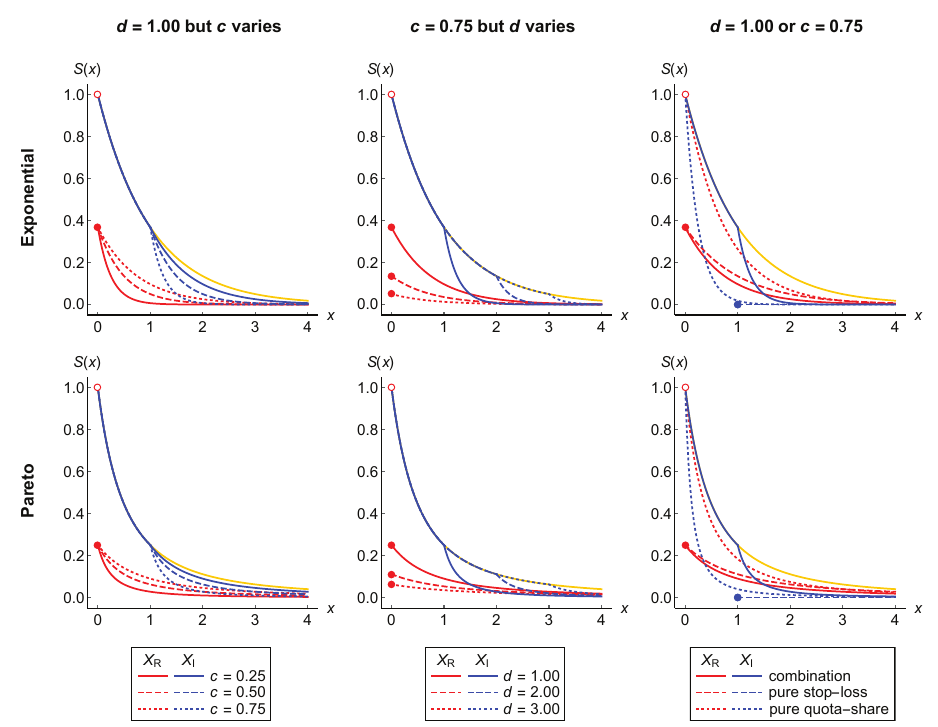
Figure 2. The curves of the survival functions S X stop-loss and quota-share reinsurance when d is fixed but c varies (on the left side) and when c is fixed but d varies (on the middle side). On the right side, they are compared to the curves of the survival functions under the pure stop-loss and the pure quota-share reinsurance. The yellow curve represents the survival function of the initial loss X that follows E ( 1 ) (on the upper side) or P ( 2 ) (on the lower